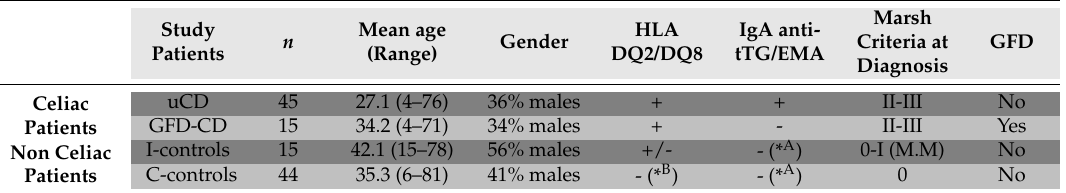
Table 1. Clinical data from patient groups included in the